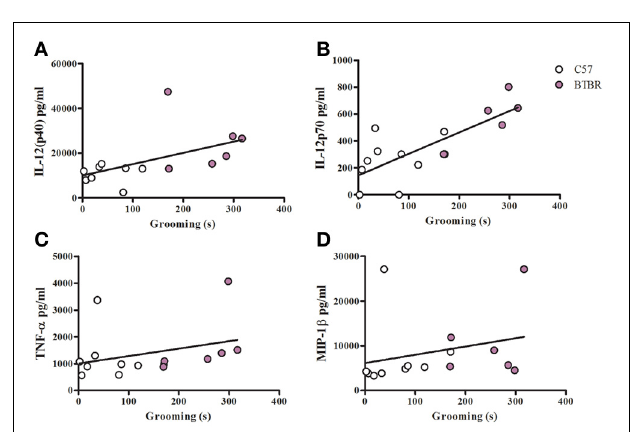
FIGURE 5 | Grooming correlation in IL-4/LPS stimulated macrophages. Scatter graphs and linear regression of IL-6 (A) , IP-10 (B) , MIP-1 β (C) , and IL-10 (D) in IL-4/LPS stimulated macrophages. Correlation coefficients ( r -value) and p- values were calculated with Spearman’s correlation analysis. (A) C57 r -value: 0.43, p- value: 0.244; BTBR r -value: 0.09, p- value: 0.872; Across strains r -value: 0.63, p- value: 0.012 ∗ (B) C57 r -value: 0.40, p- value: 0.291; BTBR r -value: 0.02, p- value: 1; Across strains r -value: 0.78, p- value: 0 . 0007 ∗ (C) C57 r -value: 0.38, p- value: 0.312; BTBR r -value: 0.71, p- value: 0.136; Across strains r -value: 0.53, p- value: 0 . 042 ∗ (D) C57 r -value: − 0.48, p- value: 0.188; BTBR r -value: − 0.77, p- value: 0.072; Across strains r -value: − 0 . 86, p- value: 0.0001 ∗ ; ∗ significant p- values.